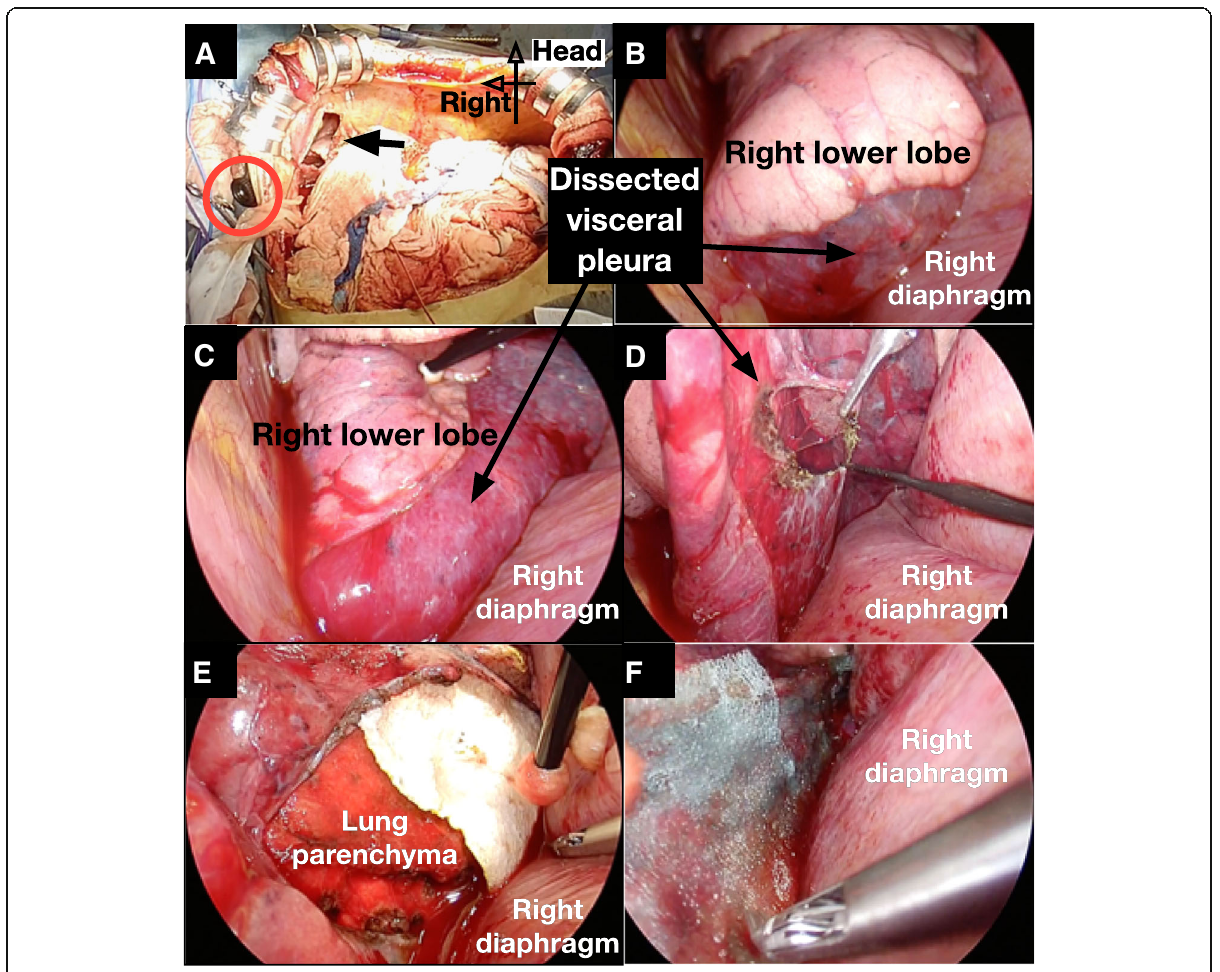
Fig. 3 Surgical procedure. a Surgical view through the reverse-T incision. A small incision was made in the right diaphragm (Arrow). An 11.5-mm port was inserted in the right tenth intercostal space (Red circle). b , c The visceral pleura of the bottom of right lower lobe was widely dissected from lung parenchyma and presented like a giant cyst. d , e The dissected pleura was opened, and fibrin sealant patches were put on the lung parenchyma under the cyst. f Polyglycolic acid (PGA) sheets were also applied on the surface of the visceral pleura after closing the air